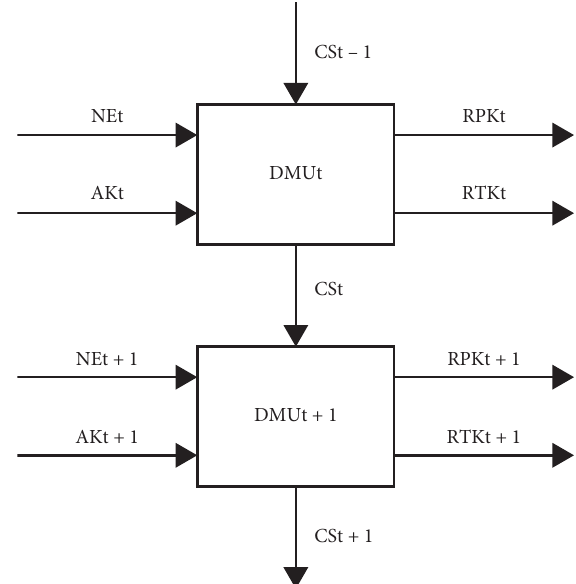
Figure 4: Two-stage series-parallel structure in